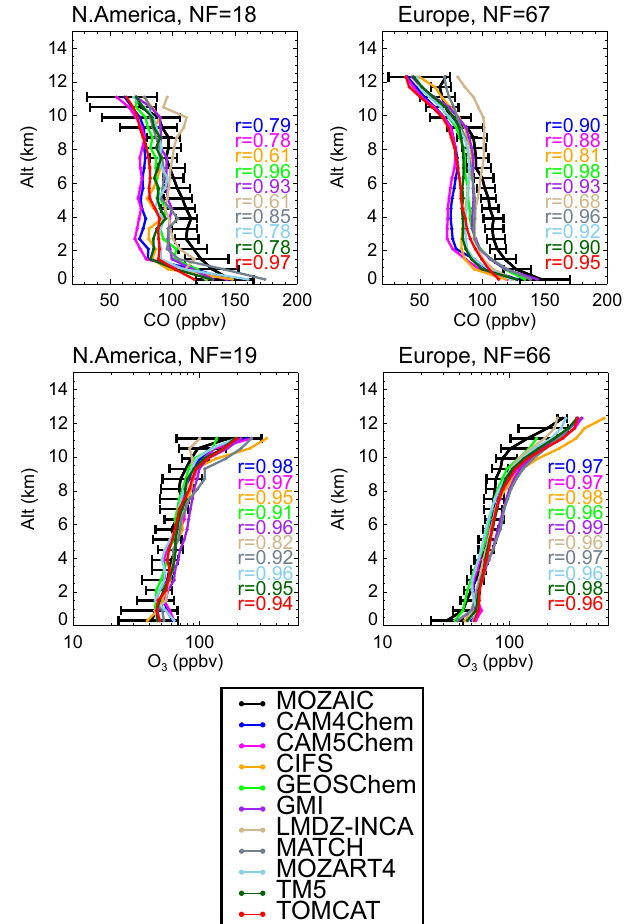
Figure 9. Vertical median profiles from the MOZAIC aircraft project made between 18 June and 14 July 2008, during ascent and descent in the regions of North America (left) and Europe (right). Observed CO (top) and O 3 (bottom) are compared to hourly simu- lated concentrations interpolated to MOZAIC airport location. All data are put into 50m bins and the error bars show the 25th and 75th percentiles of the observations in each bin. The number of profiles in each location used to calculate the regional profile averages are shown in Fig.